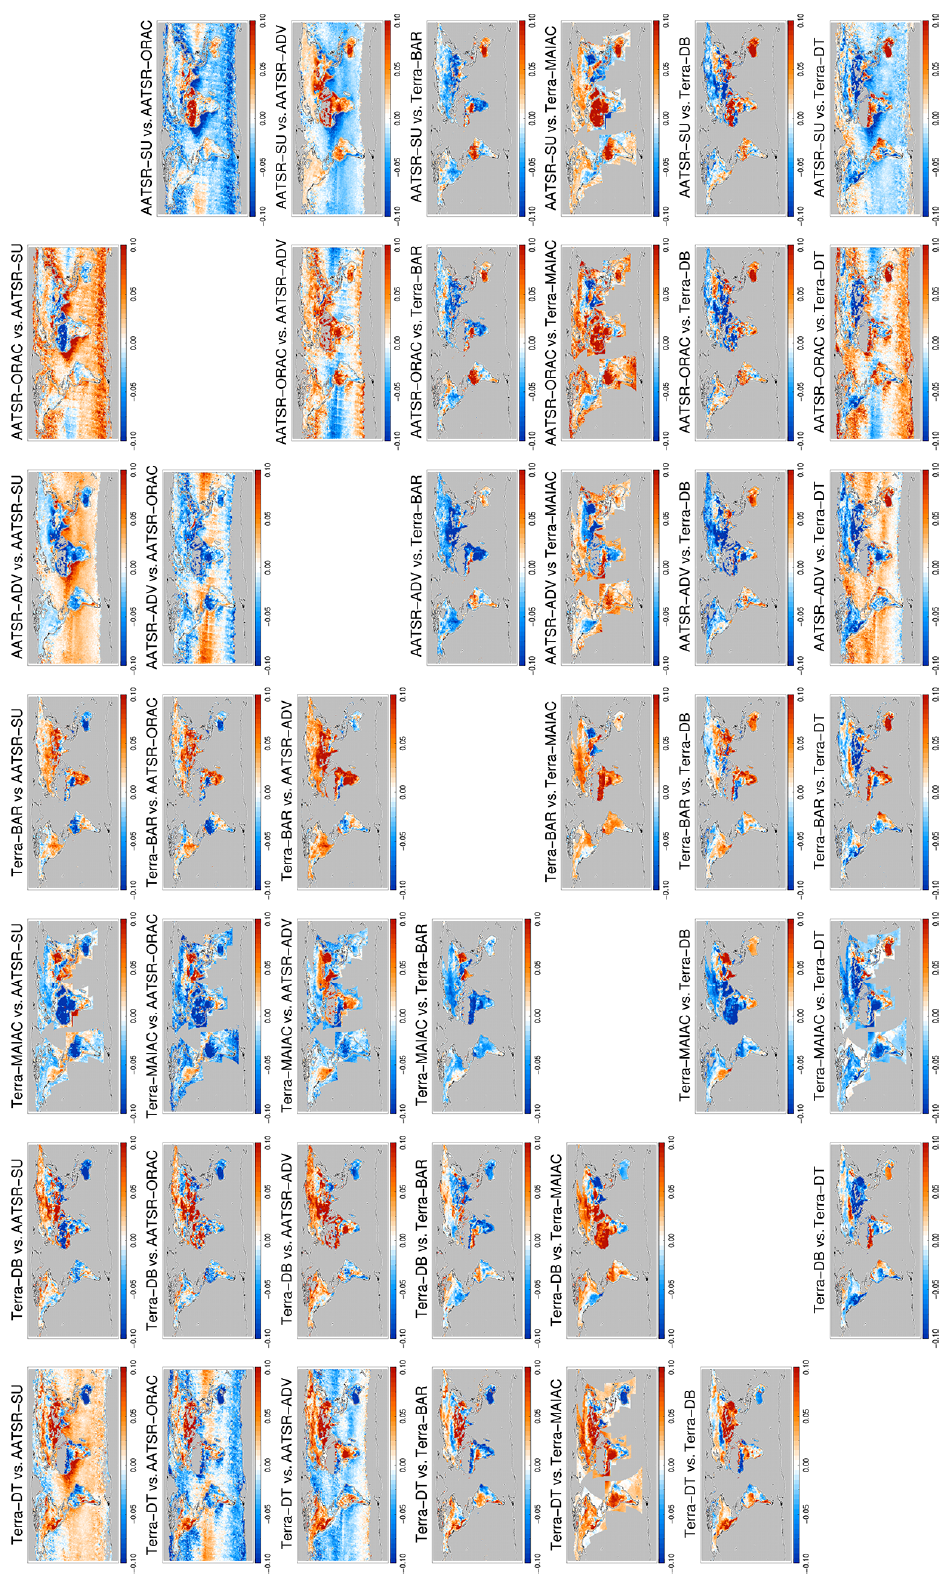
Figure 13. Global maps of the 3-year averaged difference in AOD for satellite products on morning satellites. Products were collocated pair-wise within